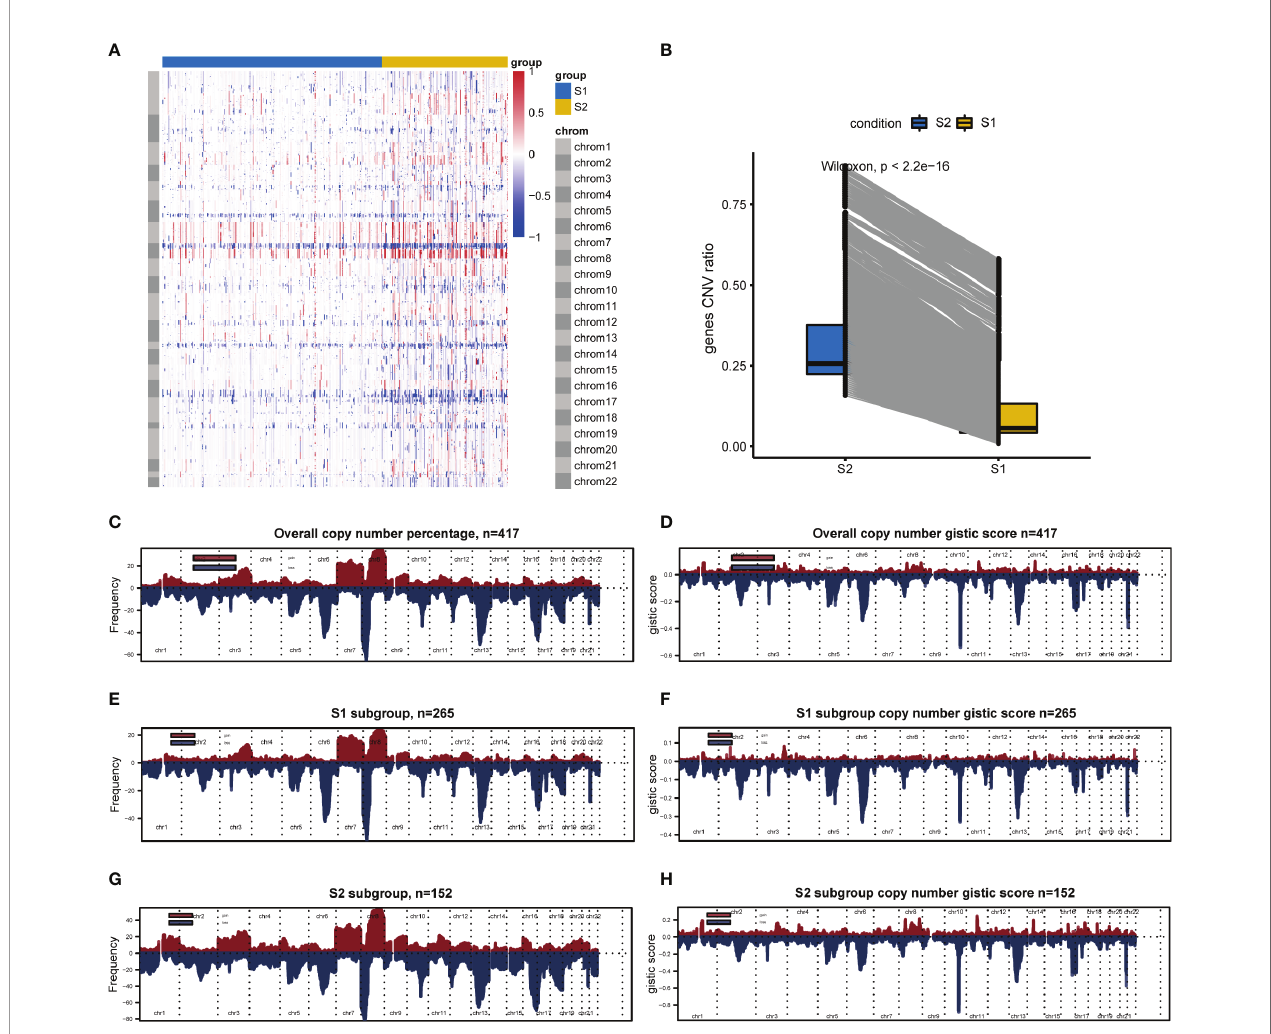
FIGURE 7 | CNVs difference analysis between S1 and S2. (A) CNVs difference analysis by Wilcoxon. (B) Hierarchical clustering. Red indicates ampli fi cation, whereas blue indicates deletion. (C – H) Chromosomal distribution of copy number by GISTIC. Red indicates ampli fi cation, whereas blue indicates